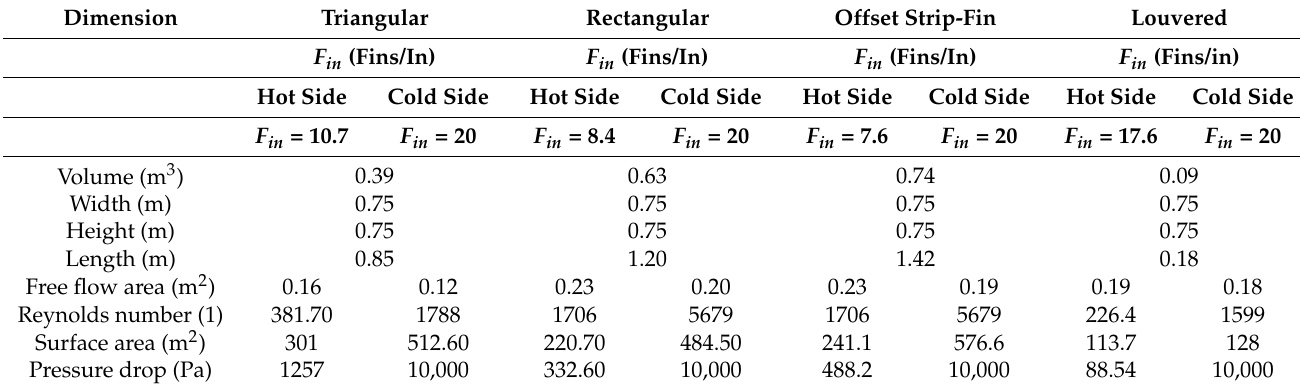
Table 8. Design results for a width of 0.75 m and height of 0.75